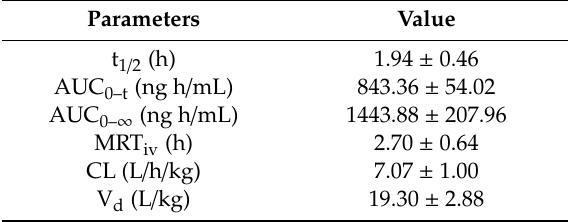
Figure 3. Plasma concentration-time profiles of gardneramine after intravenous injection of gardneramine at dose of 10 mg/kg ( n = 12). Table 6. The pharmacokinetic parameters of gardneramine in rat plasma ( n = 12).